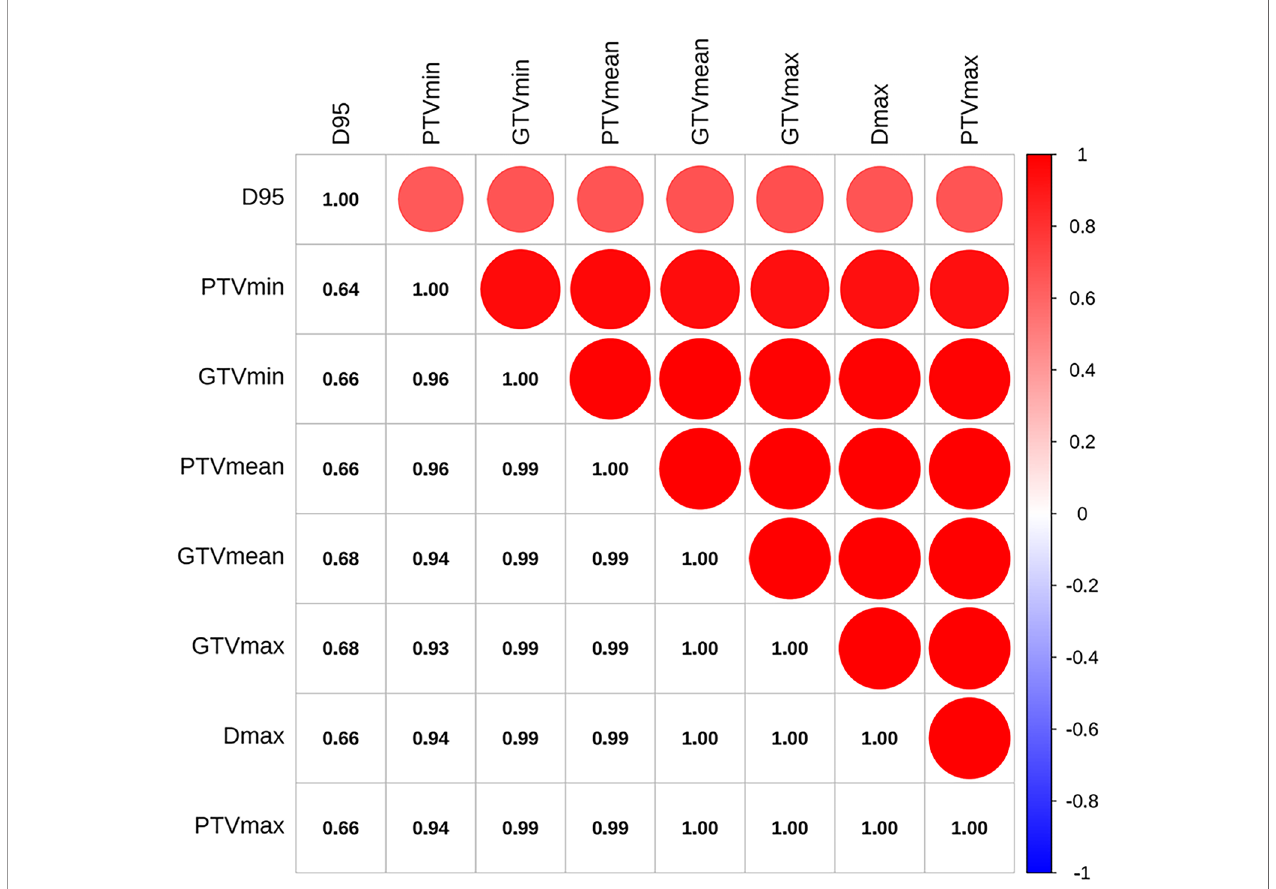
FIGURE 2 | Pearson ’ s correlation coef fi cients between pairs of dosimetric factors. D95, the prescription dose covers 95% of the target area; Dmax, the maximum dose in the whole plan; PTVmin, the minimum dose of PTV; PTVmean, mean dose of PTV; PTVmax, the maximum dose of PTV; GTVmin, the minimum dose of GTV; GTVmean, mean dose of GTV; GTVmax, the maximum dose of GTV.